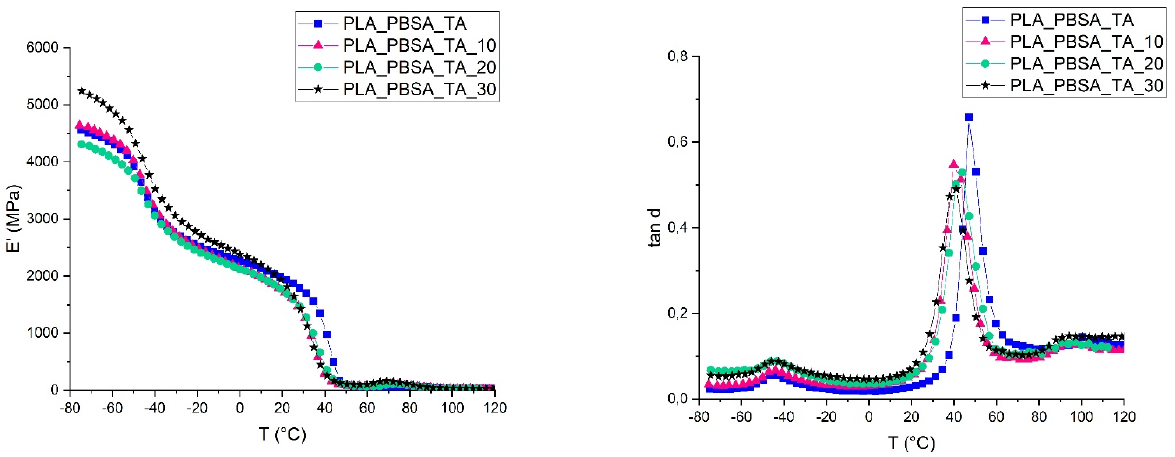
Figure 6. Variation of the storage moduli (E’) (left side) and damping factors (tan δ ) (right side) with temperature for PLA/PBSA plasticized bran composites.